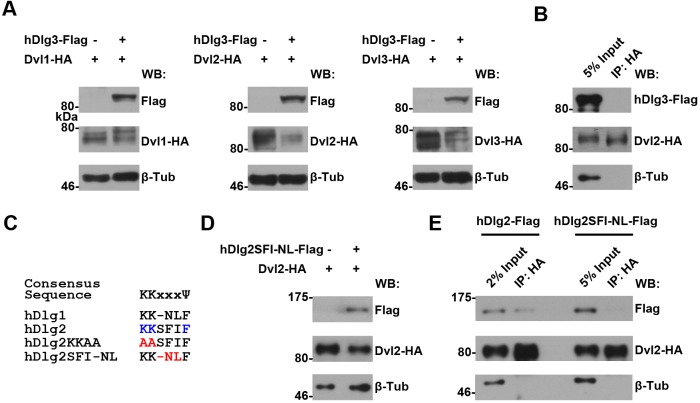
An intact K-K-x-x-x-Ψ motif is required for human Dlg proteins to stabilize Dvl2 in HEK293T cells.(A) Overexpressing hdlg3 in HEK293T cells did not increase the amount of hDvl2 proteins. (B) No interaction between hDlg3 and hDvl2 was detected by co-IP in HEK293T cells. (C) Shown is the alignment of the K-K-x-x-x-Ψ motives in human Dlg 1 and 2. Two hDlg2 mutant forms, KKAA and SFI-NL, are also compared. (D) Overexpressing the SFI-NL mutant form of hdlg2 (B) did not result in increased hDvl2 production. (E) The SFI-NL mutant form of hDlg2 displayed reduced interaction with hDvl2 in HEK293T cells when compared with that of wildtype hDlg2.